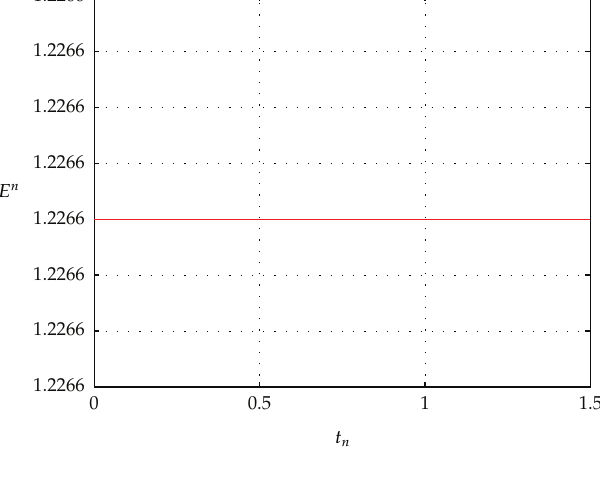
Figure 12: Conservative case.